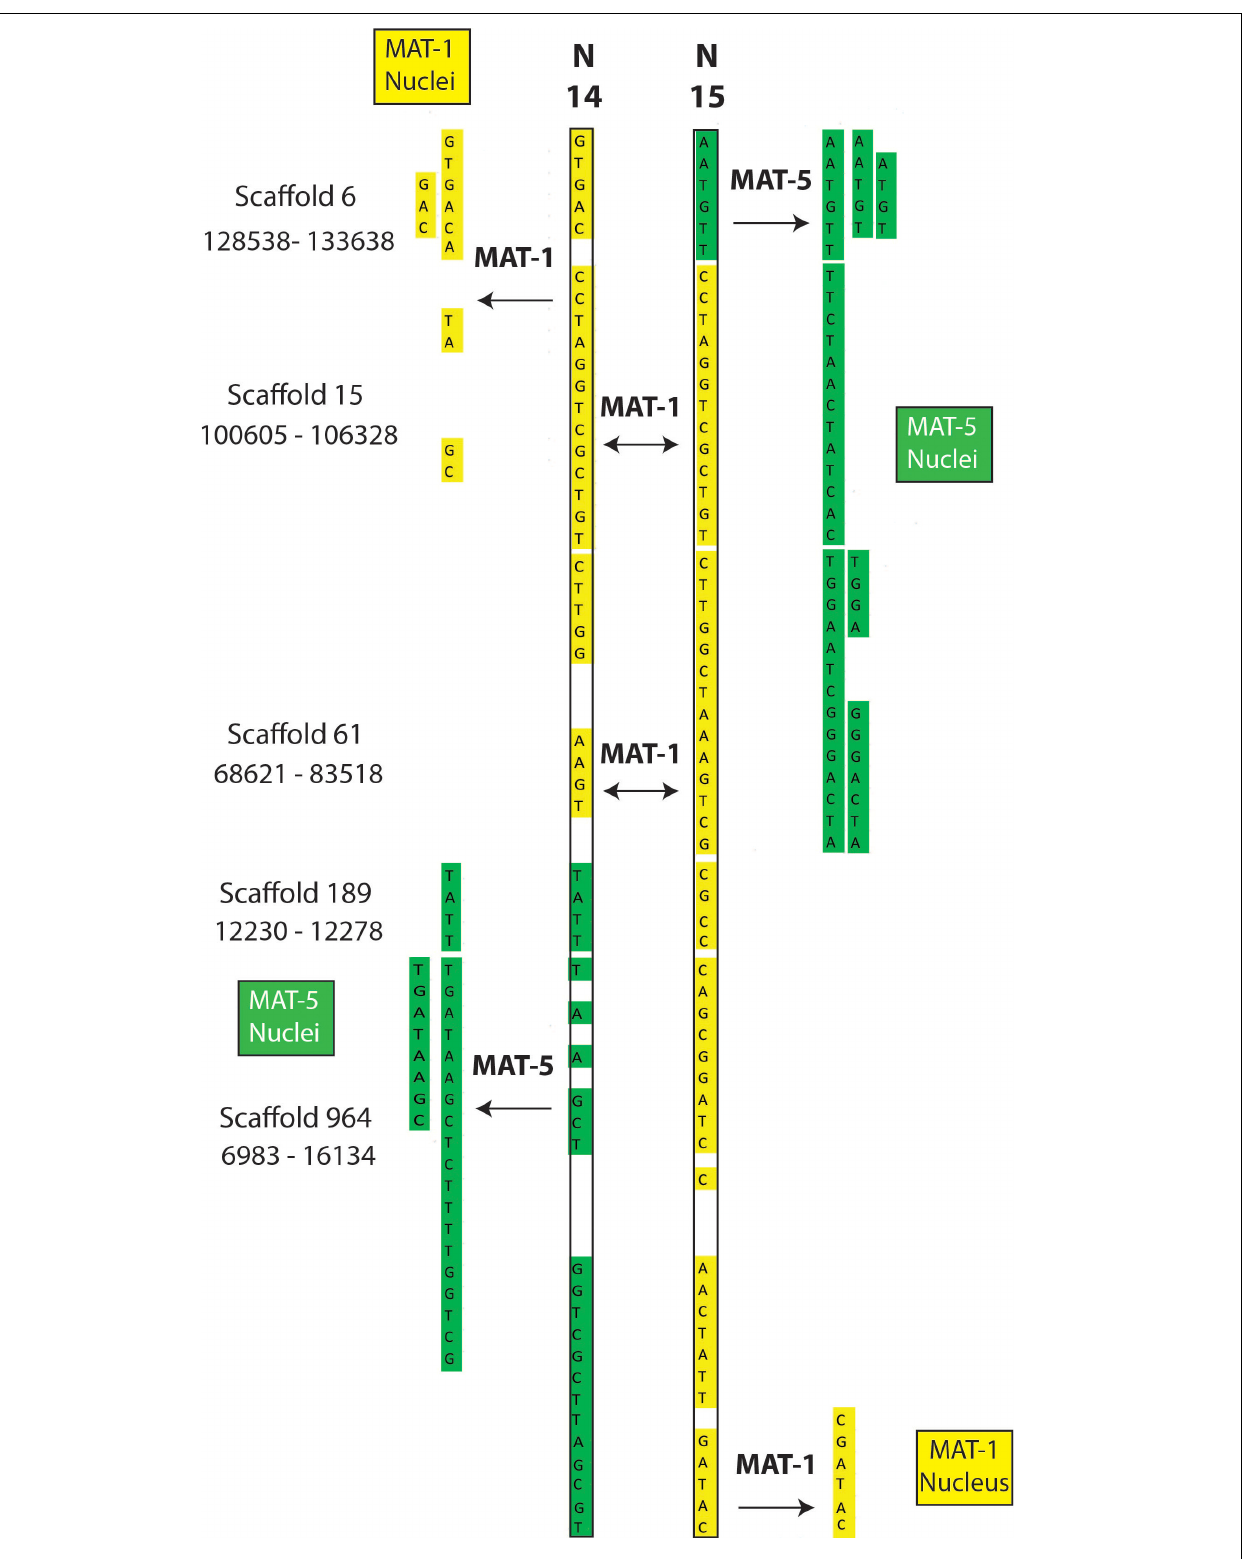
Frontiers in Plant Science |